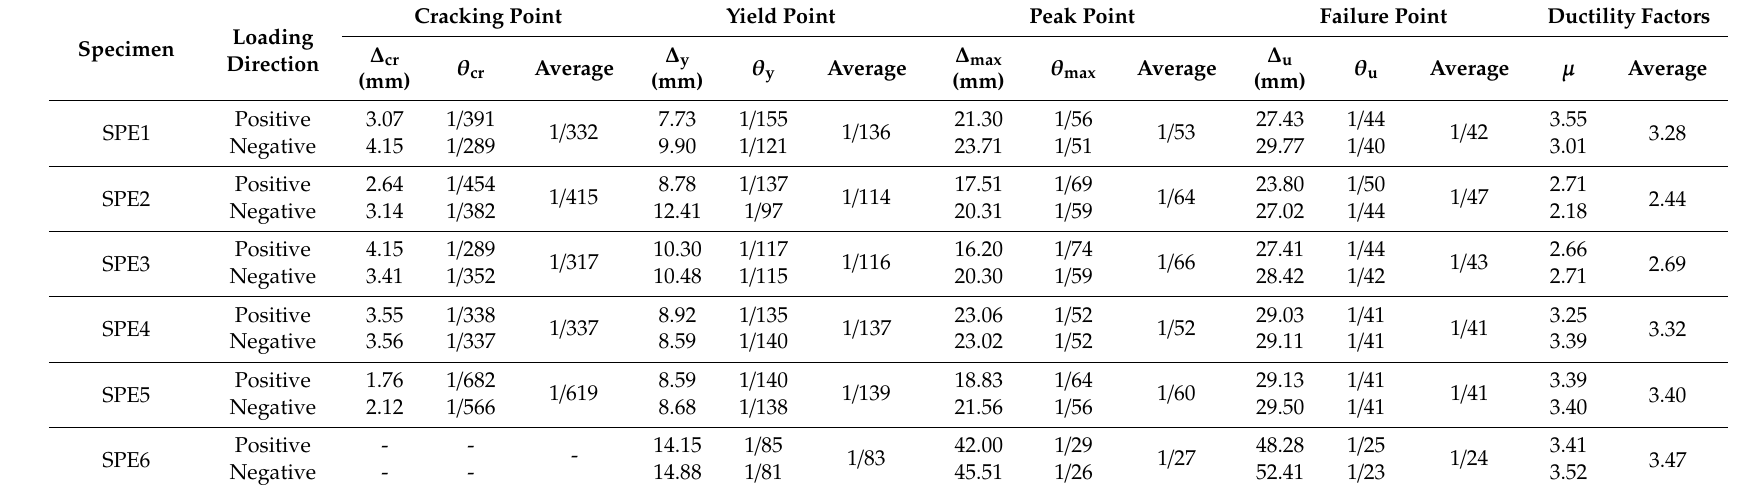
Table 7. Displacement and displacement ductility